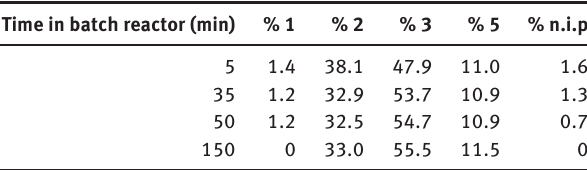
Table 3 Conversion of 1 into 3 study at about 10 g · h -1